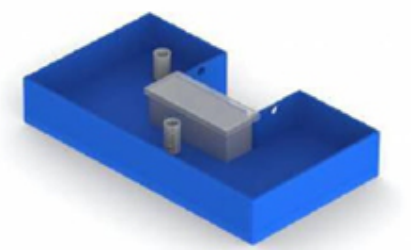
Figure 11. Final grow bed